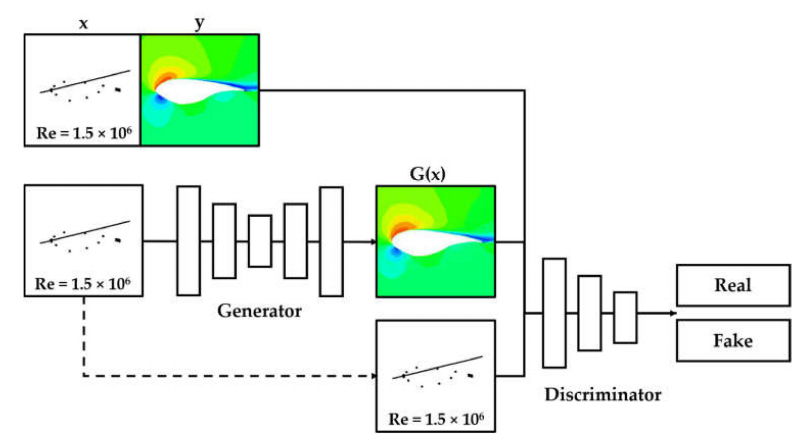
Figure 3. The flow chart for the use of pix2pix in airfoil flow field prediction.